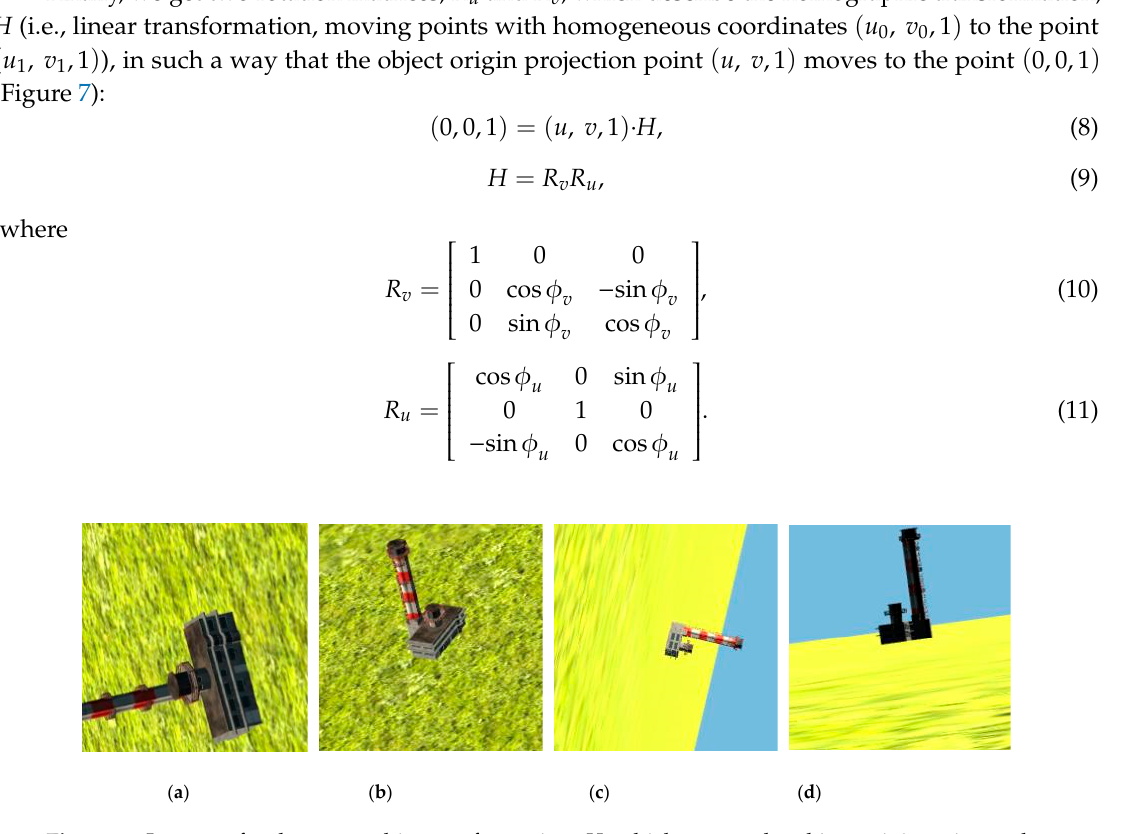
Figure 7. Images after homographic transformation, H , which moves the object origin point to the point (0,0,1) . 4 Examples of images after the transformation can be found in ( a – d )